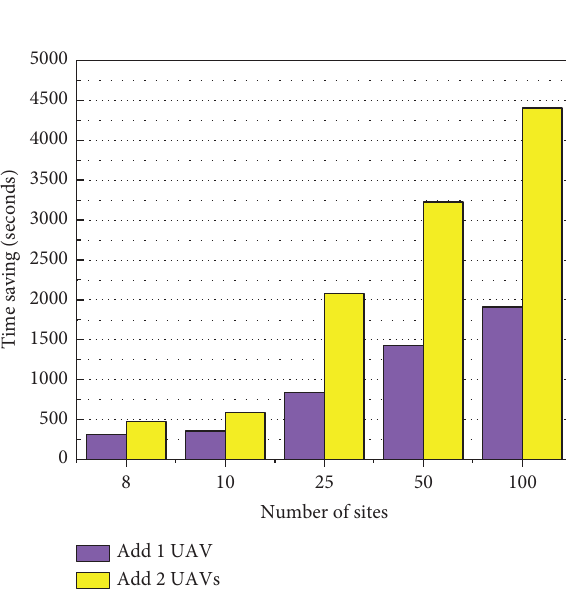
Figure 9: UAV time saving.